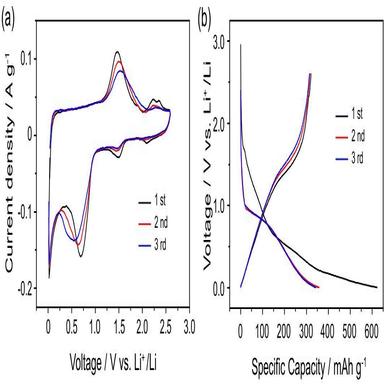
(a) CV curves of the initial five cycles and (b) galvanostatic profiles for the LMB/BxOy@C.